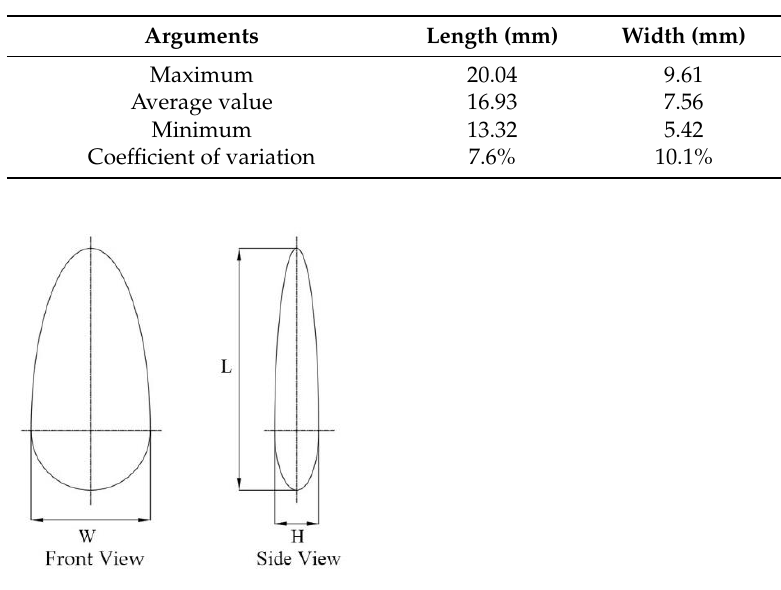
Table 1. Triaxial size of sunflower seeds.